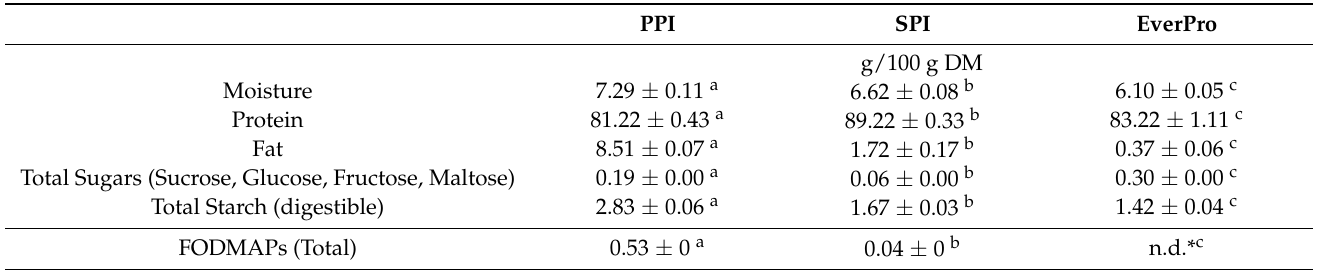
Table 1. Compositional analysis of PPI, SPI and EverPro. Values in the same row with the same lowercase letter are not significantly different from each other.